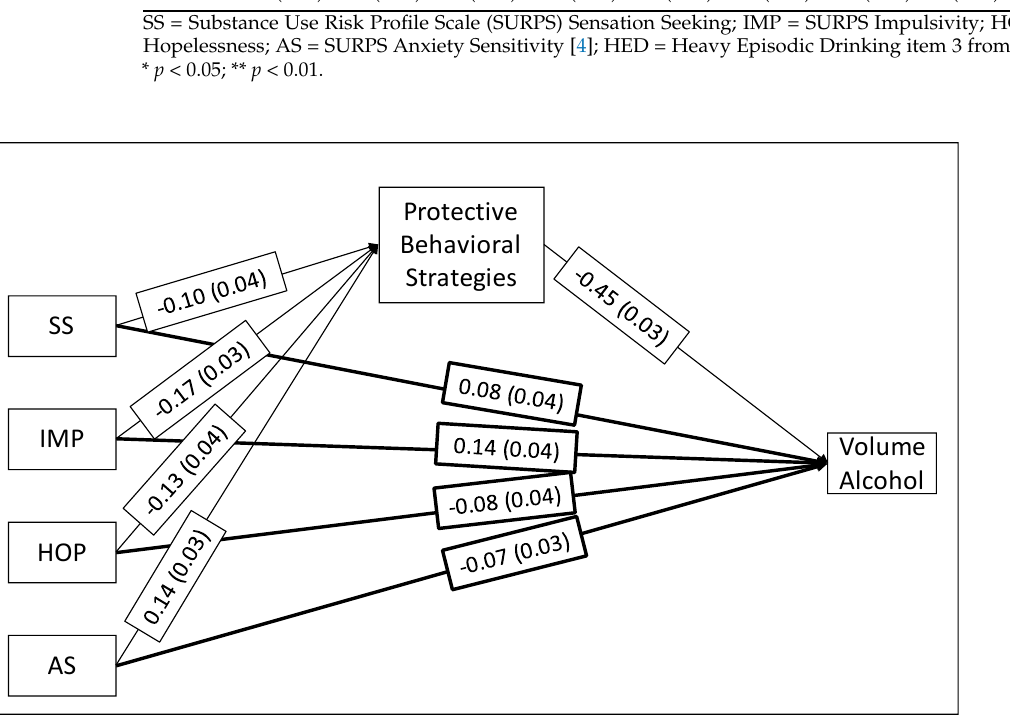
Table 2. Standardized indirect effects and standard errors of personality traits on alcohol outcomes through protective behavioral strategies, standardized direct effects, and standardized total effects. Study 1